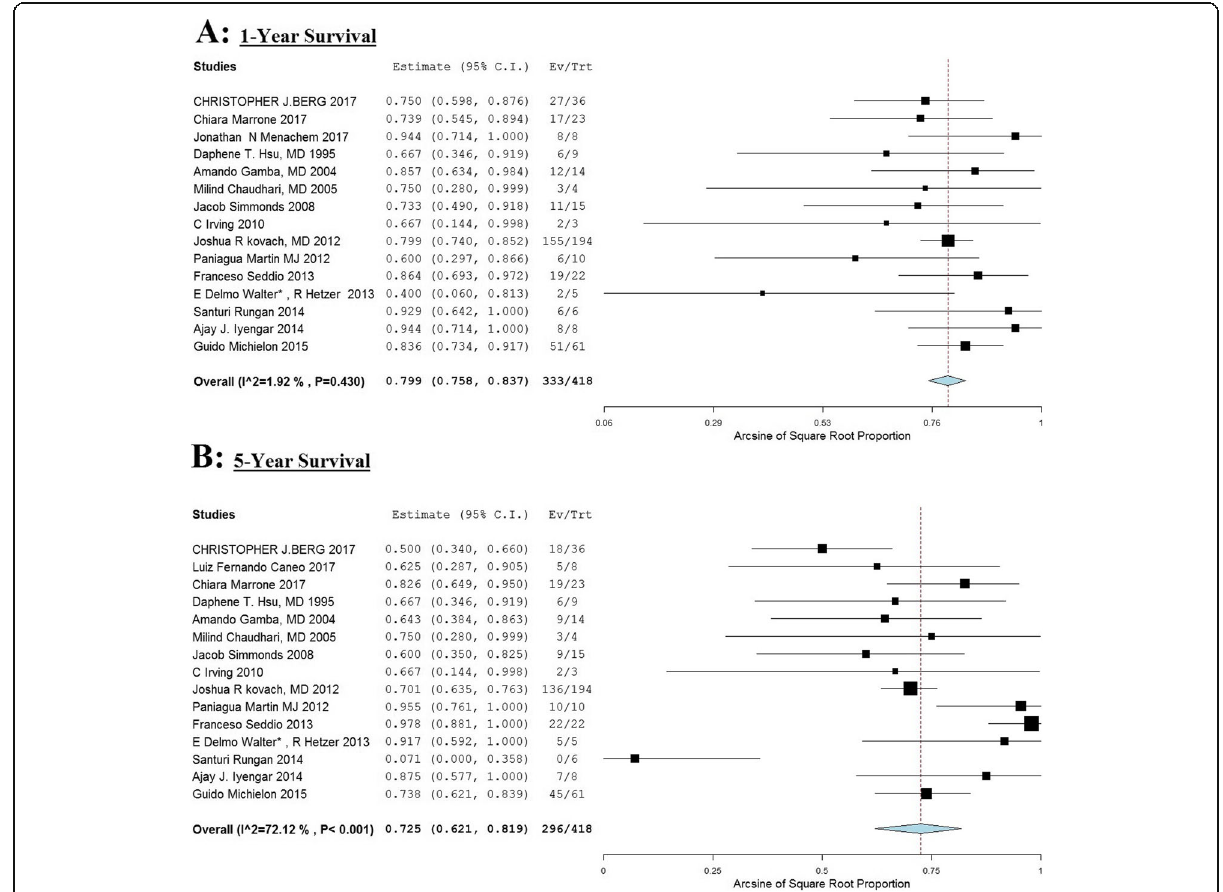
Fig. 2 Forest plots for survival outcomes of heart transplantation after failed Fontan for a 1-year and b 5-year. I^2, heterogeneity; 95% CI, 95% confidence interval; Evt/Trt,